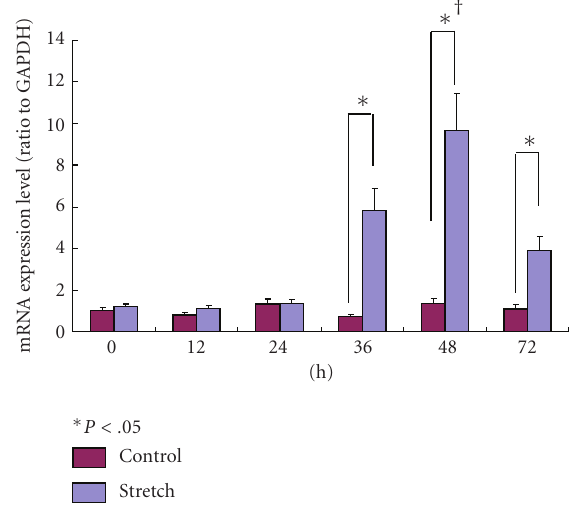
Figure 9: The expression of VEGF-mRNA in the stretching group was significantly higher than that is the control group at 24, 36, 48, and 72 hours ( P < . 05). The expression of VEGF-mRNA in the stretching group showed the highest value at 48 hours and decreased with time ( † ).